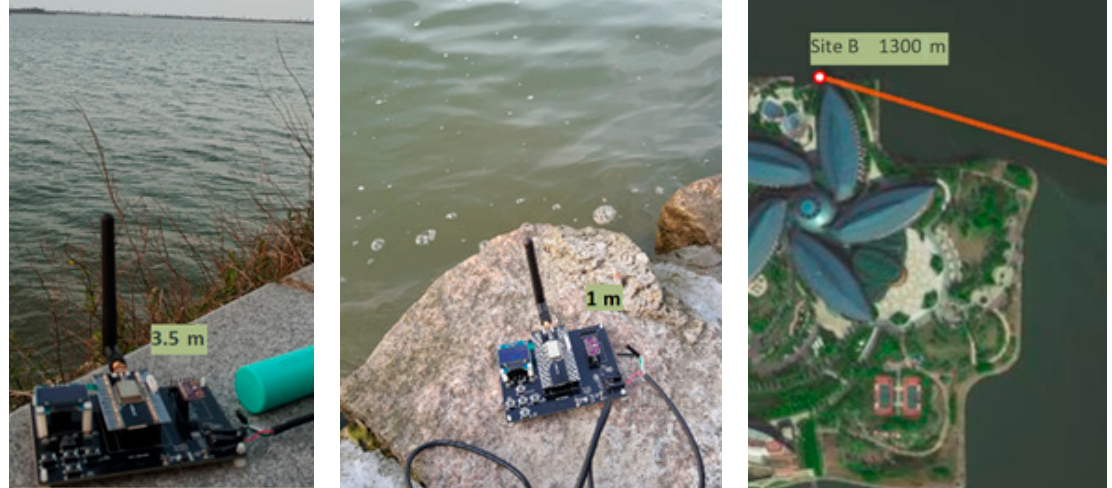
Figure 2. The sending nodes with different height locations above water level at Site B.